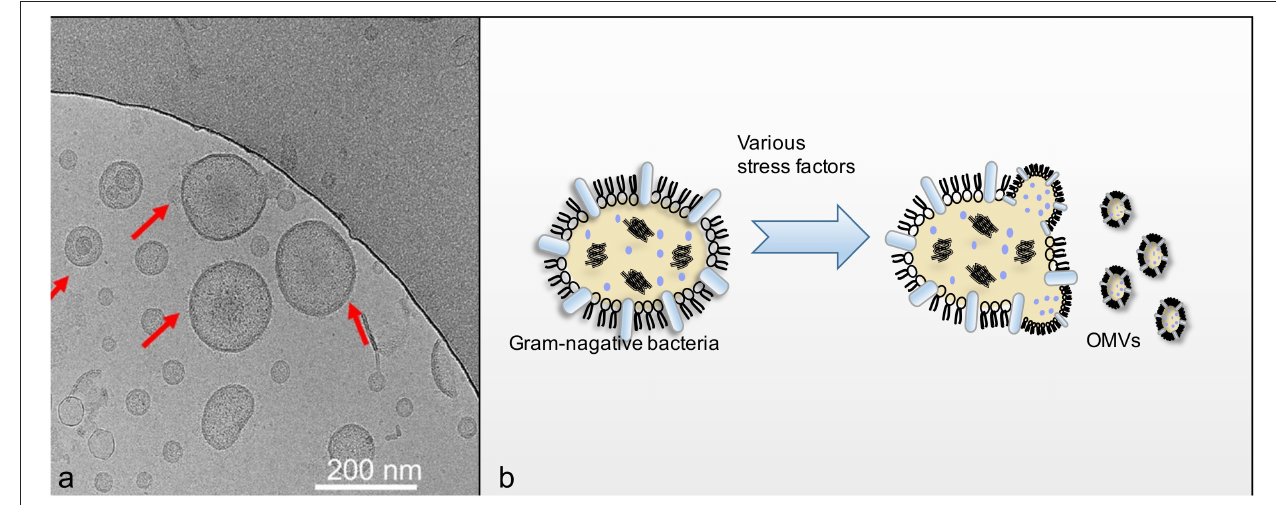
FIGURE 1 | (a) Showed that Cryo-EM imaging of OMVs (Liu et al., 2016). OMVs derived from the flagellin-deficient S.typhimurium were visualized using cryo-EM. The red arrows indicate the visible OMVs; (b) showed schematic diagram of OMVs secretion process.